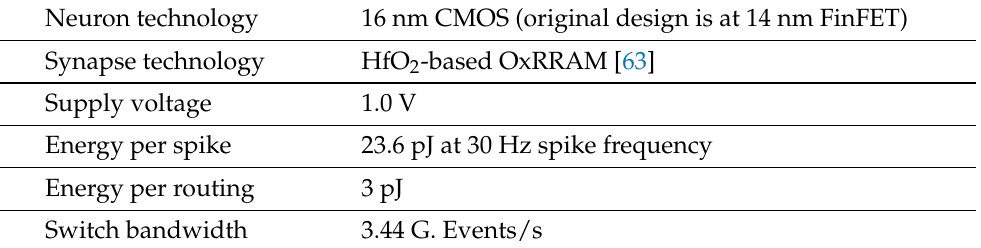
Table 2. Major simulation parameters extracted from Loihi